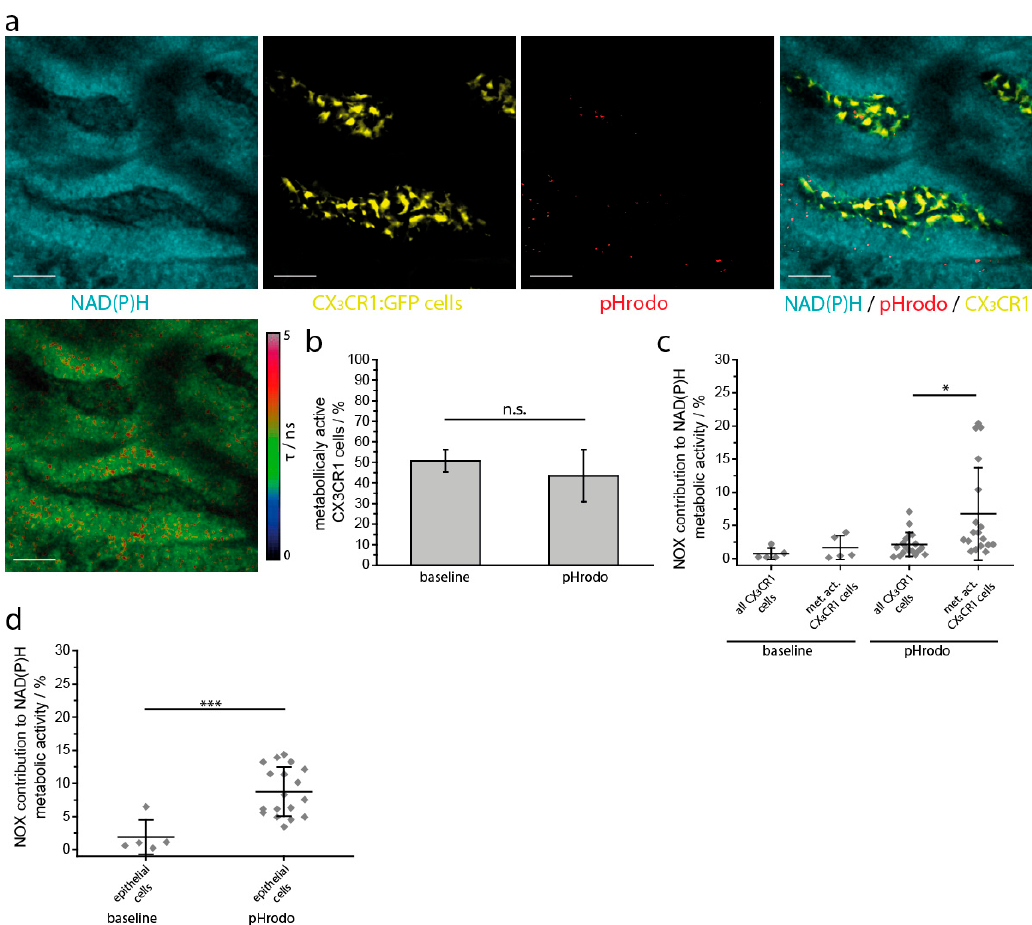
Figure 6. Intravital marker-free FLIM reveals compartmentalization of NOX enzymatic activity in the small intestine upon inflammatory stimulation. ( a ) The upper row shows single and merged fluorescence images of intestinal villi in a CX3CR1-GFP mouse locally treated with S. aureus pHrodo beads: cyan represents NAD(P)H fluorescence, yellow represents GFP fluorescence, red represents phagocytosed pHrodo beads in a low pH environment. At physiologic pH the pHrodo beads are non-fluorescent. A volume of 100 µL with 10 [8] pHrodo beads was added directly to the exposed inner surface of the small intestine. The image in the bottom row represents the corresponding fluorescence lifetime image of enzyme-bound NAD(P)H of the entire tissue. Scale bar = 50 µm. ( b ) Overall NAD(P)H enzymatic activity in the myeloid compartment of the small intestine under steady-state conditions and upon S. aureus pHrodo stimulation, as measured by NAD(P)H FLIM. ( c ) NOX enzymes contribution to the overall NAD(P)H enzymatic activity in myeloid cells under steady-state conditions and upon S. aureus pHrodo treatment, as calculated from NAD(P)H FLIM measurements. ( d ) NOX enzymes contribution to the overall NAD(P)H enzymatic activity in the epithelial compartment under steady-state conditions and upon S. aureus pHrodo treatment. The graphs ( b – d ) display results acquired in n = 5 mice, 1 baseline area and 3–5 areas after treatment in each mouse. Analysis in ( d ) was performed using one-way ANOVA statistical tests (* p < 0.05; *** p < 0.001, n.s.: not